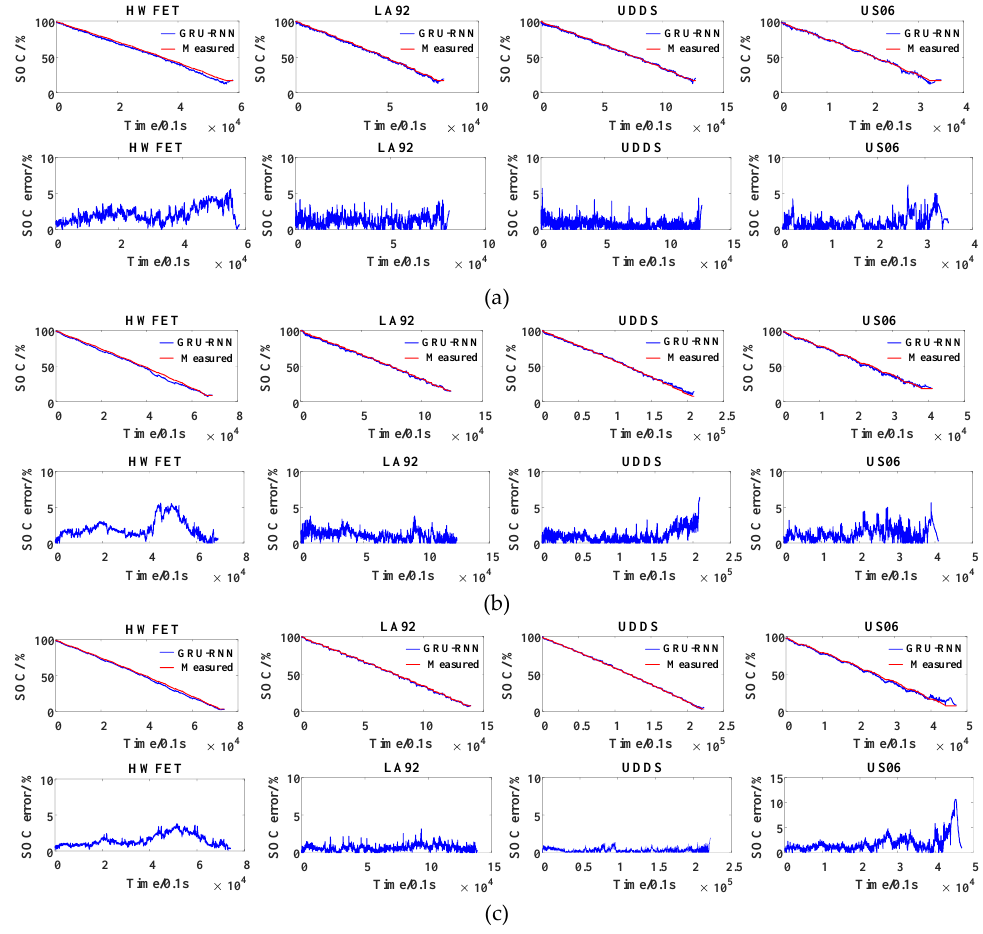
Figure 7. SOC estimation curves trained on single-temperature data: ( a ) 0 °C; ( b ) 10 °C; ( c ) 25 °C. Table 1. SOC estimation result of the GRU-RNN trained on single-temperature data.